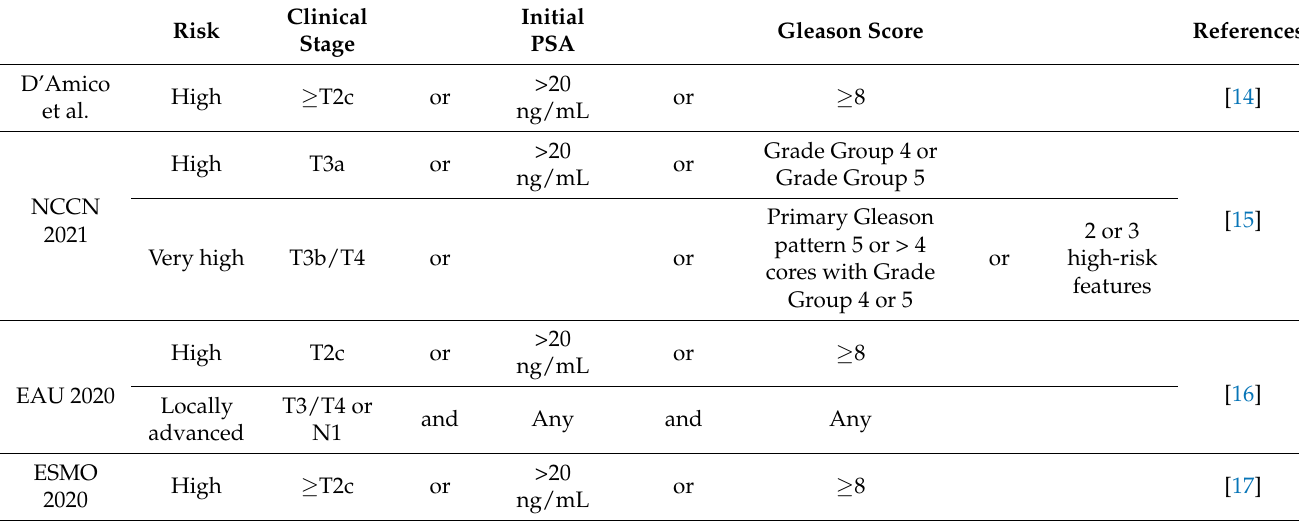
Table 1. Definition of high-risk prostate